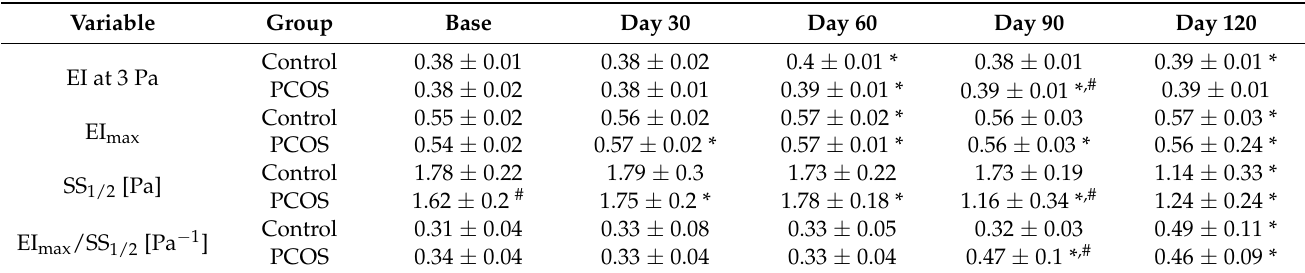
Table 5. Changes in the parameters describing the red blood cell deformability in Control and polycystic ovary syndrome (PCOS) group.